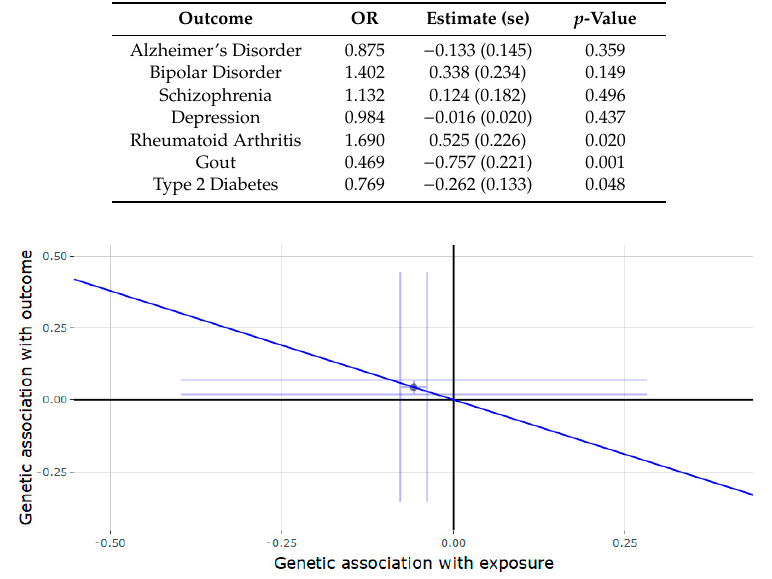
Table 2. Mendelian Randomization (MR) using variants from the JMJD1C Locus—Inverse Variance Weighted (IVW) Method.